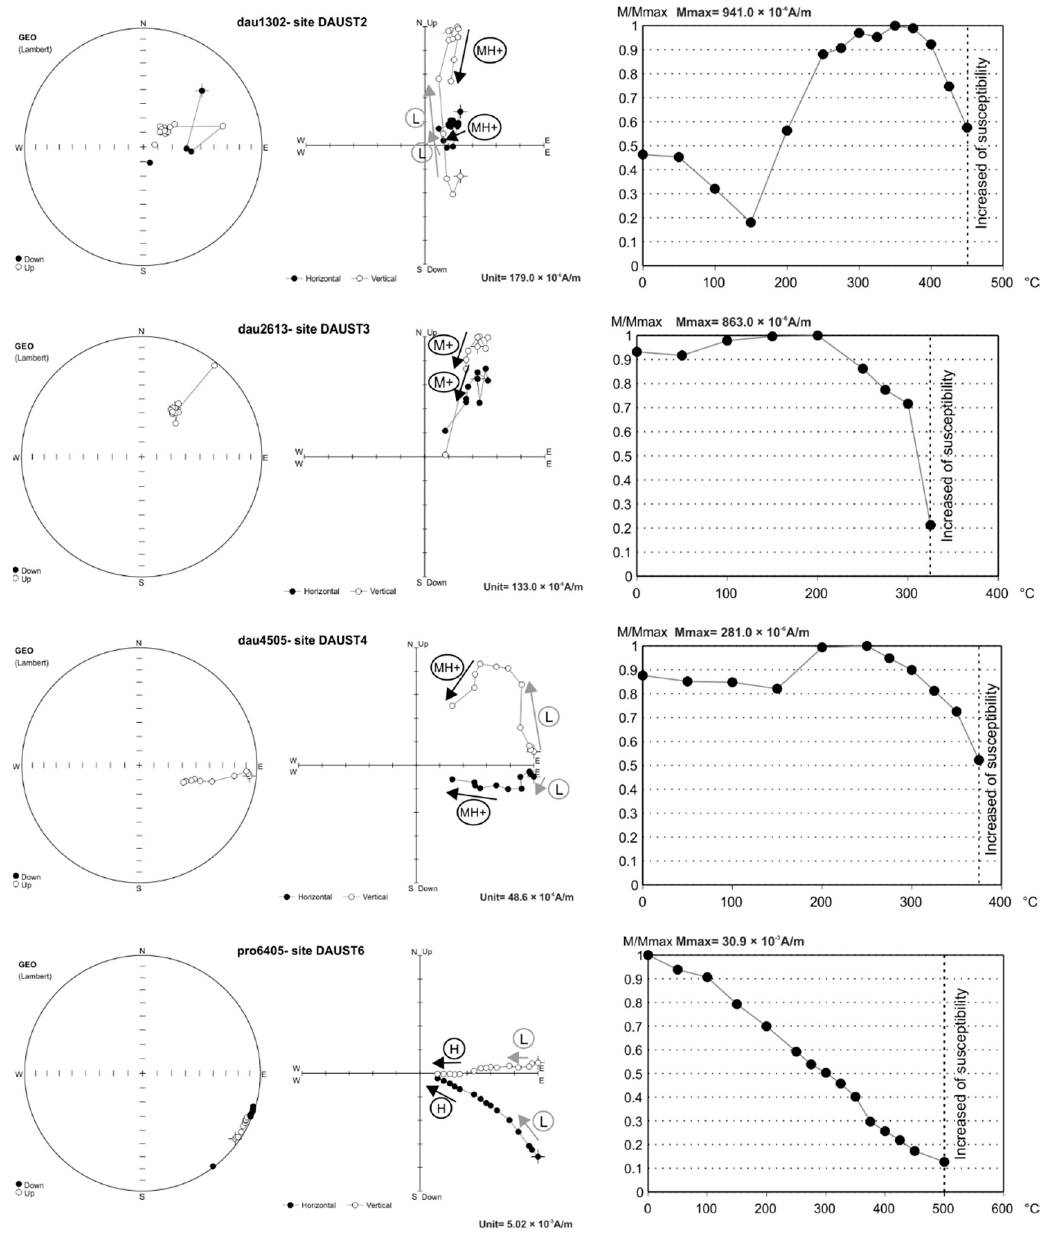
Figure 10. Examples of the most characteristic demagnetization diagrams used to calculate palaeomagnetic site mean directions of metadolerites from SW Oscar II Land. Left column—equal area; middle column—Zijderveld diagrams; right column—normalized intensity decay plots; diagrams are presented for in situ orientation; on equal area points located on upper and lower hemisphere were marked as open and filled symbols respectively; on Zijderveld diagrams open and filled symbols means projections onto vertical and horizontal planes correspondingly, low components marked by grey arrows, medium-high components marked by black arrows, components calculated using the “anchored line fit” method marked by “+”.